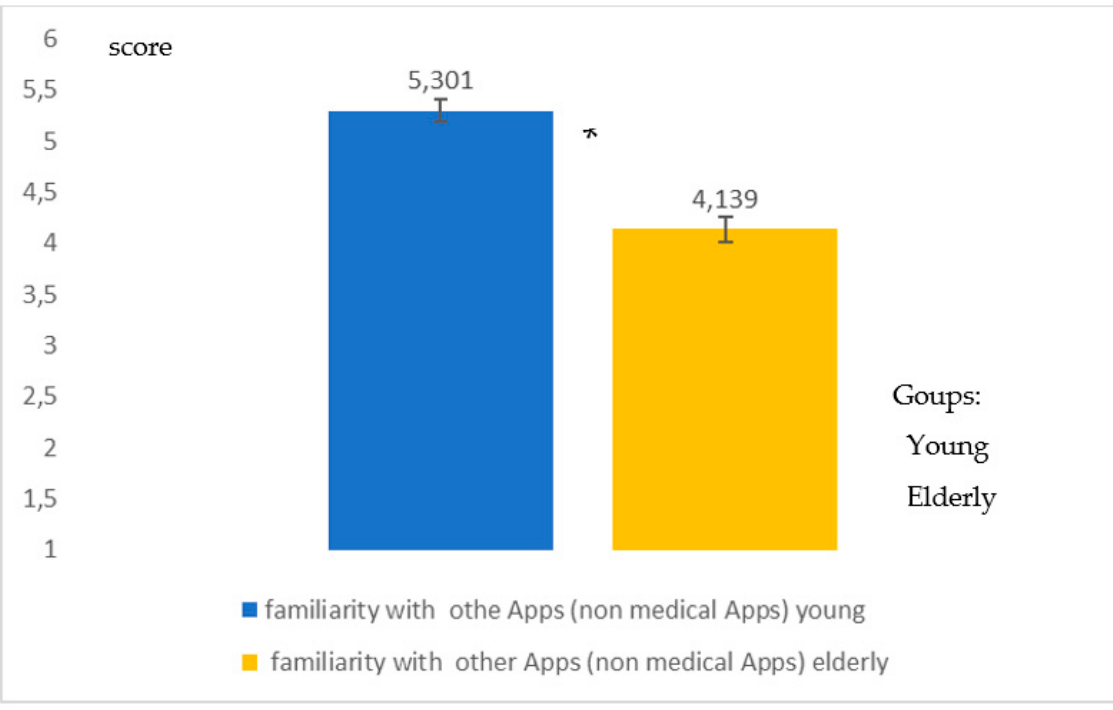
Figure 8. Differences in the degree of familiarity with other Apps (non-medical Apps) for young people and the elderly. The graphic indicates a high difference ( p = 0.008) between the two groups of young * and elderly people.